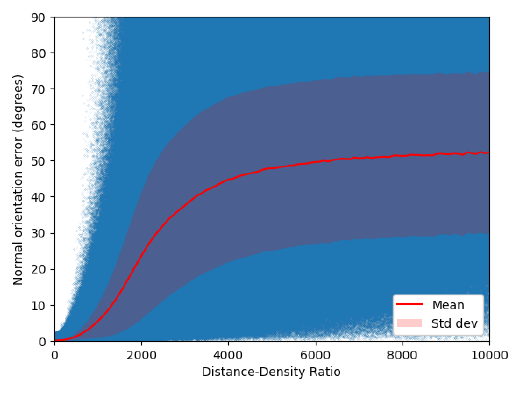
Figure 4. Normal deviation results. Scatter plots illustrate how loss of significance and normal error is a function of point spacing and point coordinate magnitude. Each plot point represents the calculated result of a single cloud point. Plots on the left were generated with the float data type, images on the right with the double data